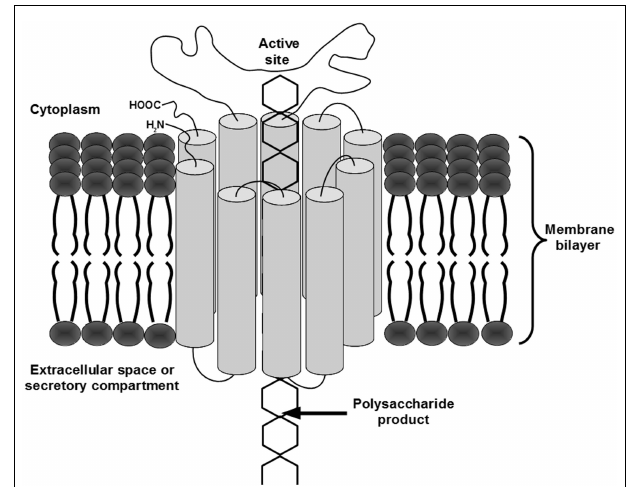
FIGURE 1 |A model for dual-function GT transport mechanism. The TMHs of the enzyme are depicted as cylinders connected by curved lines representing the extra-membrane regions of the protein. A polymer is shown being transported through a pore formed by theTMHs, from the cytosolic active site where sugars are added, across the membrane to the extracellular space or lumen of the secretory pathway.